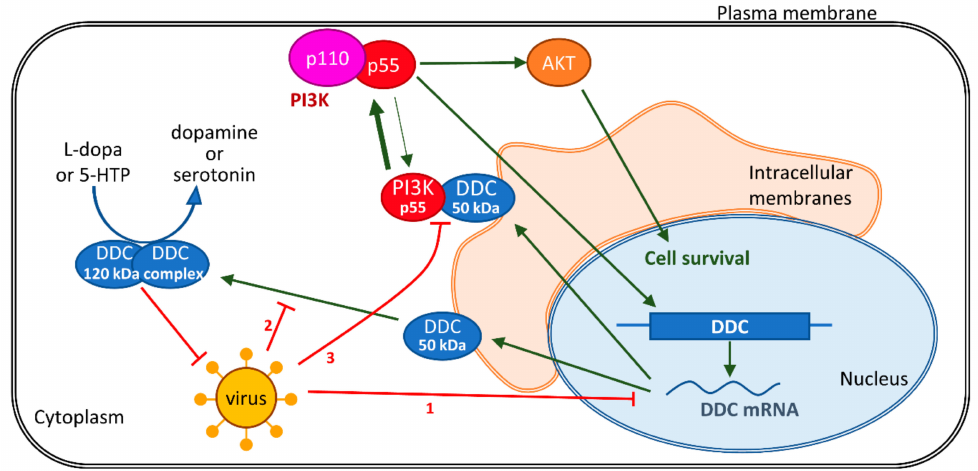
Figure 9. Schematic representation of the proposed mechanism concerning the relationship between viral infection, DDC, and PI3K / AKT pathway. DENV or HCV infection downregulates DDC at three di ff erent levels: (1) downregulates DDC mRNA, (2) reduces the release of the 50 kDa DDC monomer from intracellular membranes and subsequent formation of the 120 kDa dimeric complex, possibly representing the catalytically active form of DDC, and (3) disturbs the binding between the 50 kDa DDC monomer and PI3K p55 subunit, which releases PI3K p55 to interact with PI3K p110 and increases the activity of the PI3K / AKT pathway in favor of cell survival and viral replication during all stages of HCV infection and at the early phase of DENV infection. In turn, the enzymatic activity of DDC downregulates DENV and HCV propagation.